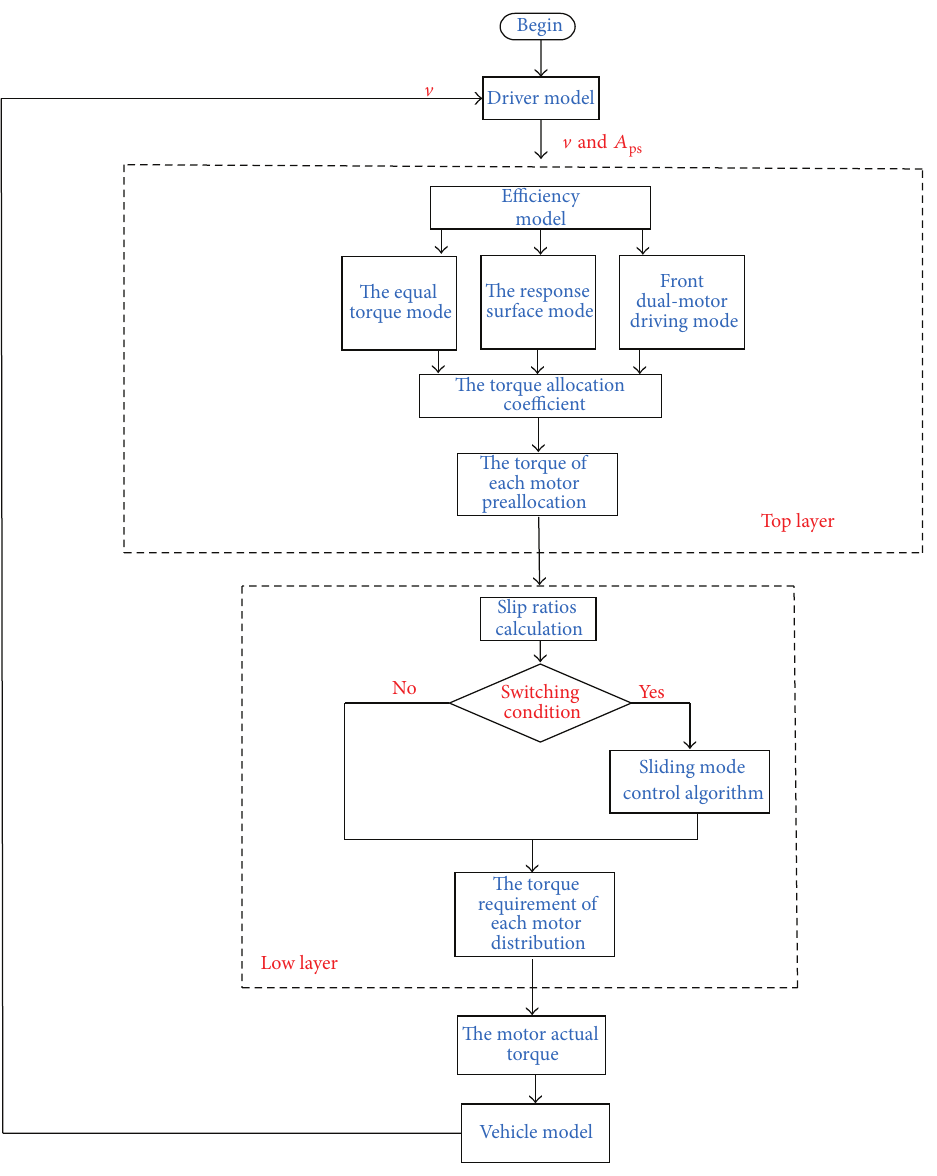
Figure 6: The traction control